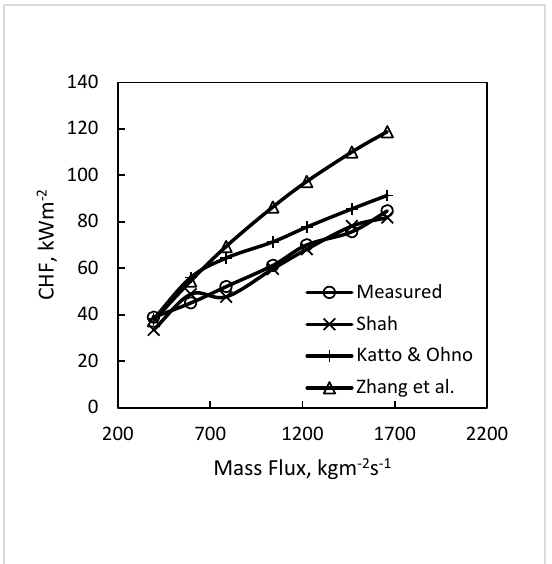
Figure 8. Comparison of the data from Celata et al. (1994b) [15] for the R-12/R-114 mixture of 0.0.136/0.864 mole in a tube with some general correlations. Pressure is 1.2 MPa, and inlet subcooling is 23 K.